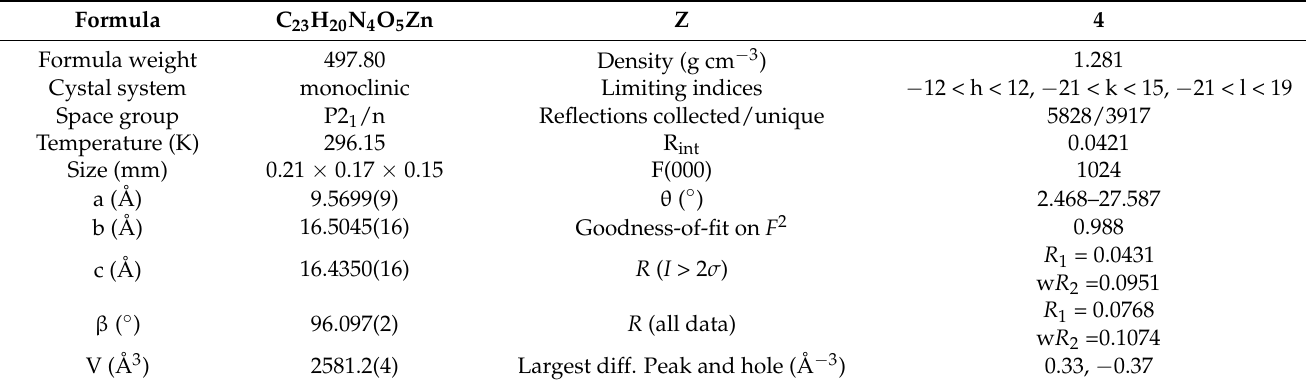
Table 2. Crystallographic data of complex 1 .